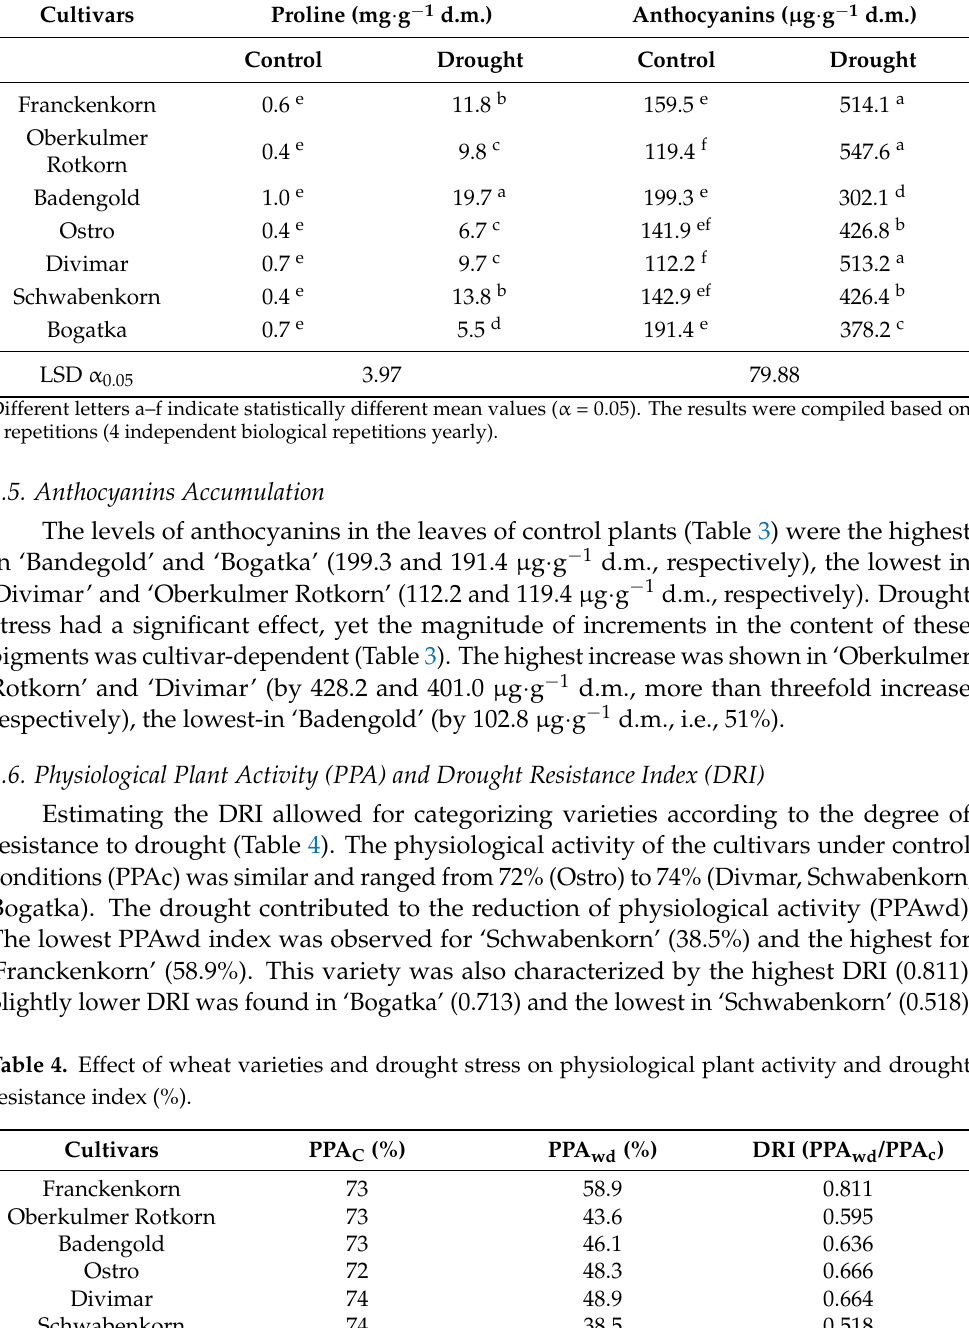
Table 3. Effect of wheat cultivars and drought stress on free proline and anthocyanins accumulation. Cultivars Proline (mg · g − 1 d.m.) Anthocyanins ( µ g · g − 1 d.m.) Control Drought Control Drought